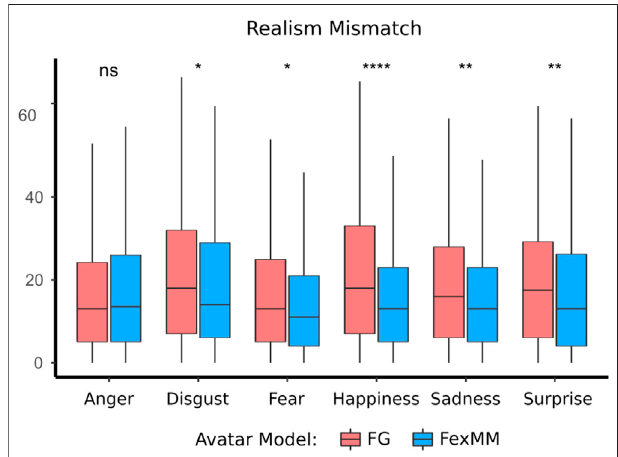
FIGURE 10 | Boxplot of behavioral realism ratings comparing the two avatar types. Level of signi fi cance is indicated by ** ( p < 0 . 01 ) and **** ( p < 0 . 001 ) .Theboxesdenotetheinterquartilerangeandthemedian.Outliers are indicated as observations that lay outside 1.5 times the interquartile range of the interindividual distributions. The outliers were not eliminated for subsequent statistical analyses.